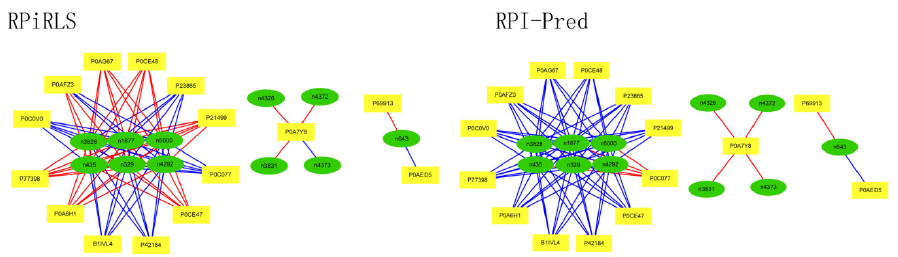
Figure 4. Comparison of the long non-coding RNA-protein interaction networks predicted by the RPiRLS and RPI-Pred methods, for Escherichia coli .